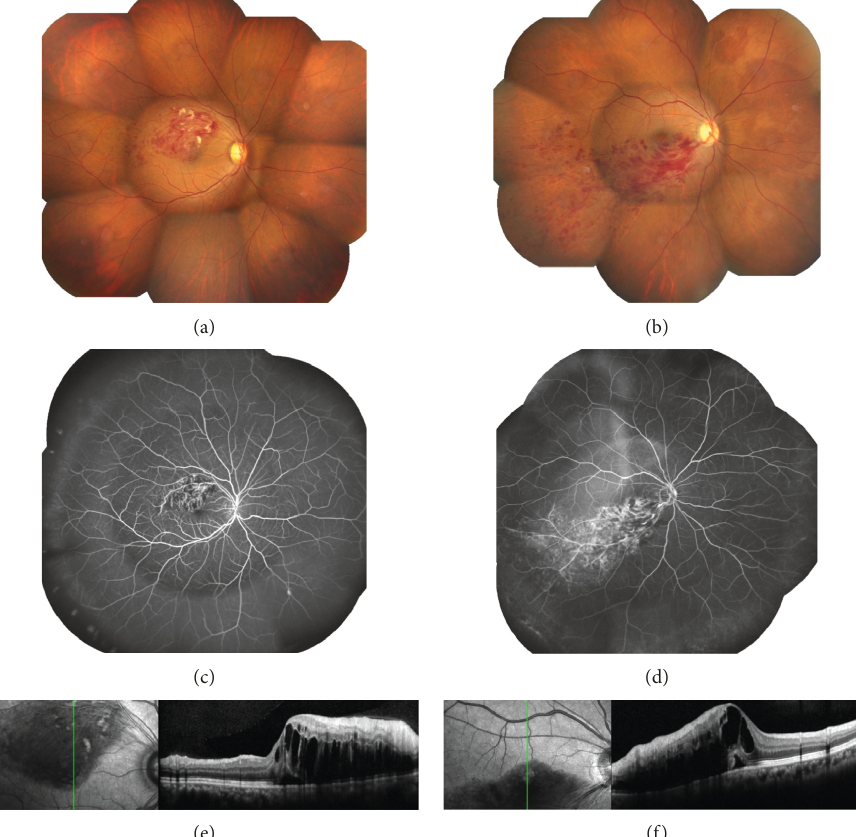
Figure 1: Color fundus photograph. (a) Macular branch retinal vein occlusion (BRVO). (b) Major BRVO. Fluorescein angiography. (c) Mild retinal hypoxia in macular BRVO. (d) Mild retinal hypoxia in major BRVO. Optical coherence tomography. (e) Macular edema and serous retinal detachment can occur in macular BRVO, even if retinal hypoxia is mild. (f) Macular edema and serous retinal detachment can also occur in major BRVO despite mild retinal